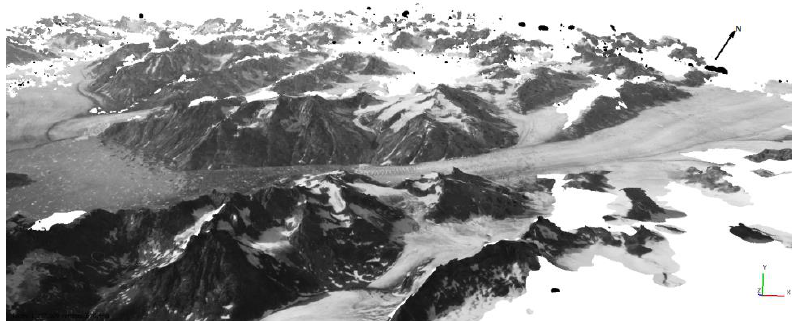
Figure 17. A detail of the 3D model—the Knud Rasmussen Glacier in the 1930s.